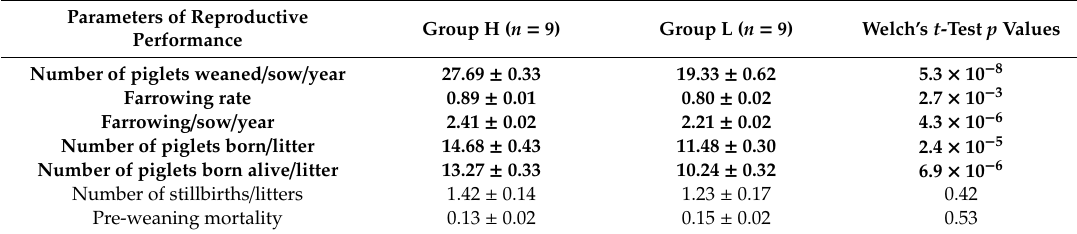
Table 1. Parameters of reproductive performance in high- and low-reproductive performance groups. Parameters of Reproductive